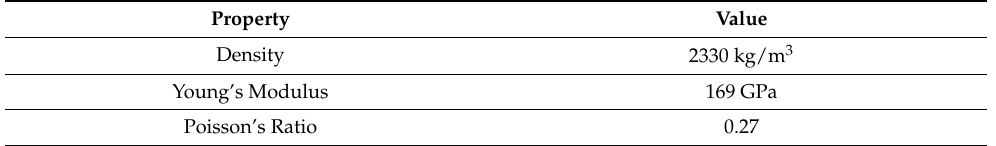
Table 2. The material parameters of gyroscope.